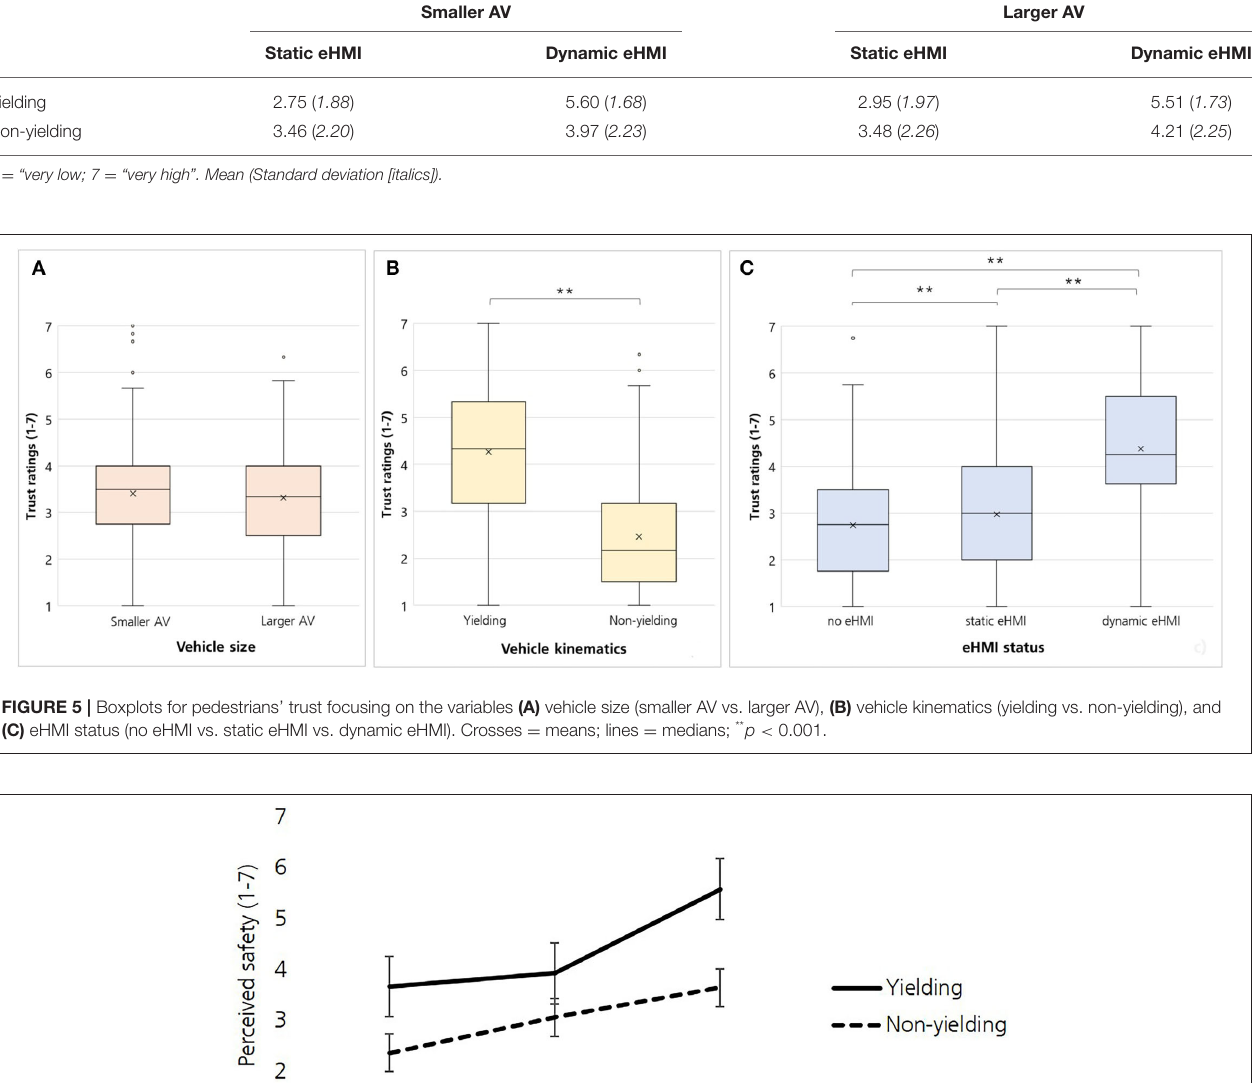
sized AVs in a shared space as an example of a low-speed and low-distance traffic scenario. The results indicated that pedestrians’ willingness to cross is influenced by the size of the AV. Moreover, the use of vehicle kinematics and eHMI communication can lead to high willingness to cross, and high trust- and safety ratings. Nevertheless, when the dynamic eHMI indicated a yielding intent by the vehicle, although the vehicle did not yield, pedestrians’ perceived safety still increased compared